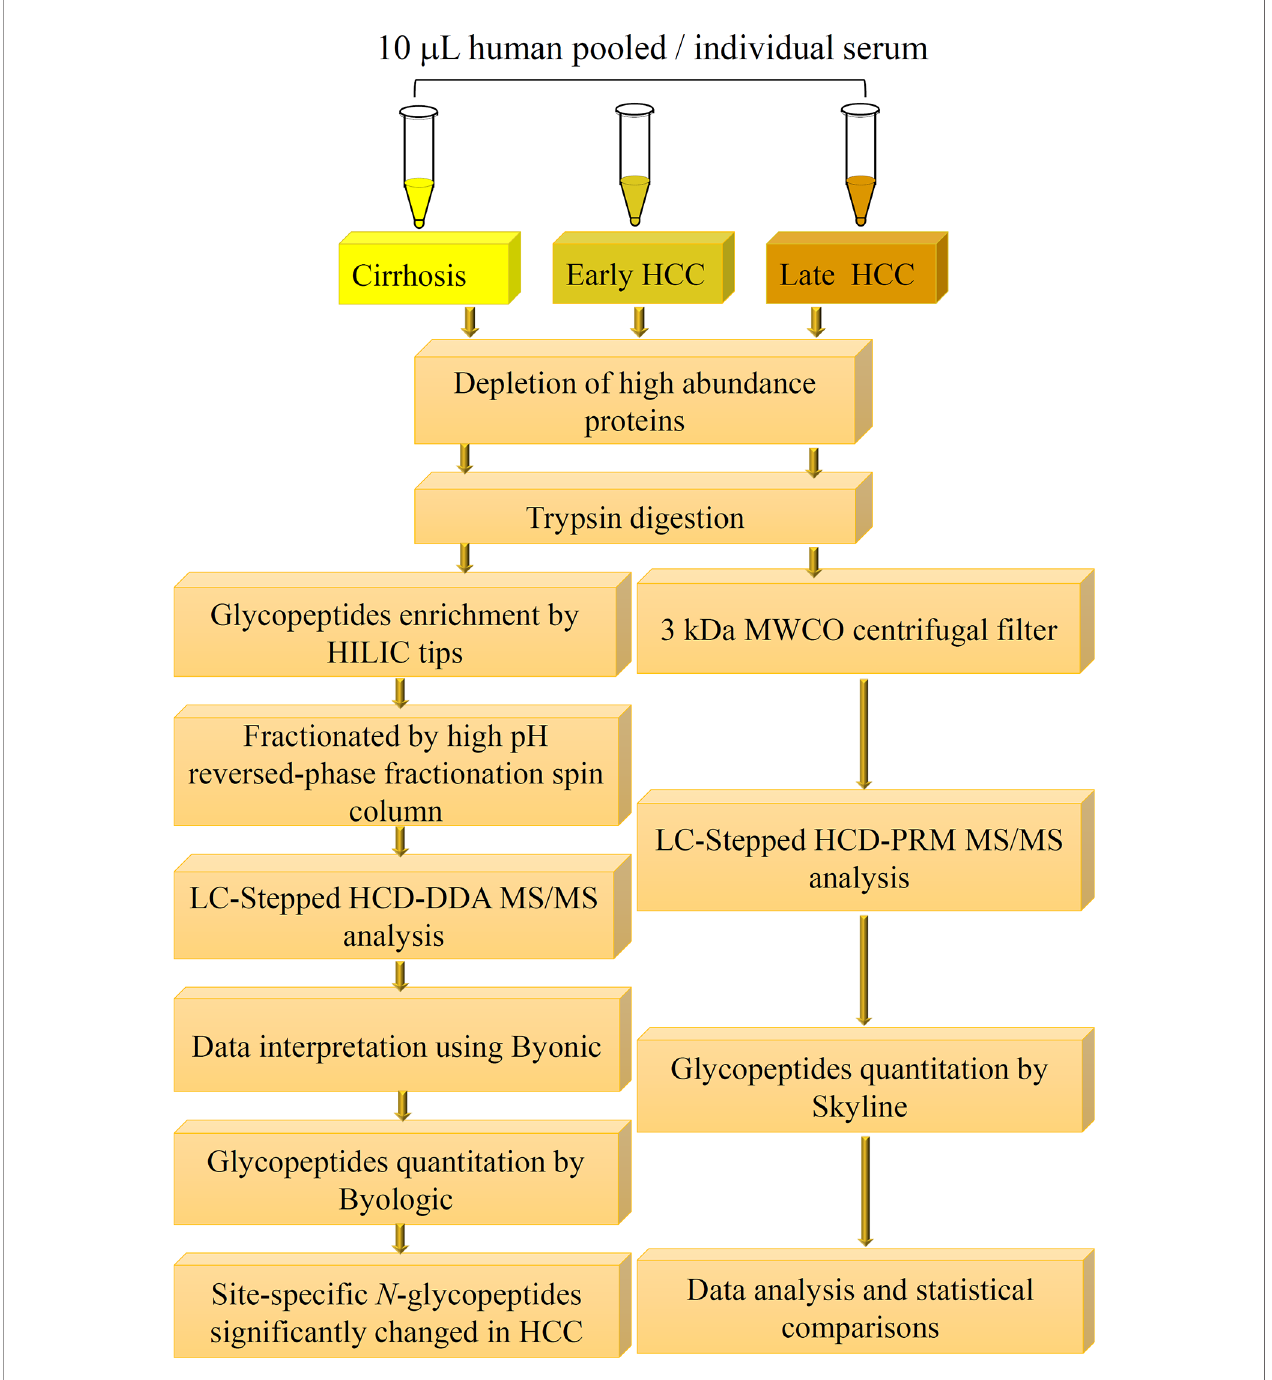
FIGURE 1 | Work fl ow of quantitative LC-Stepped HCD analysis of intact N-glycopeptides derived from serum of patients between NASH-related liver cirrhosis, early-stage HCC, and late-stage